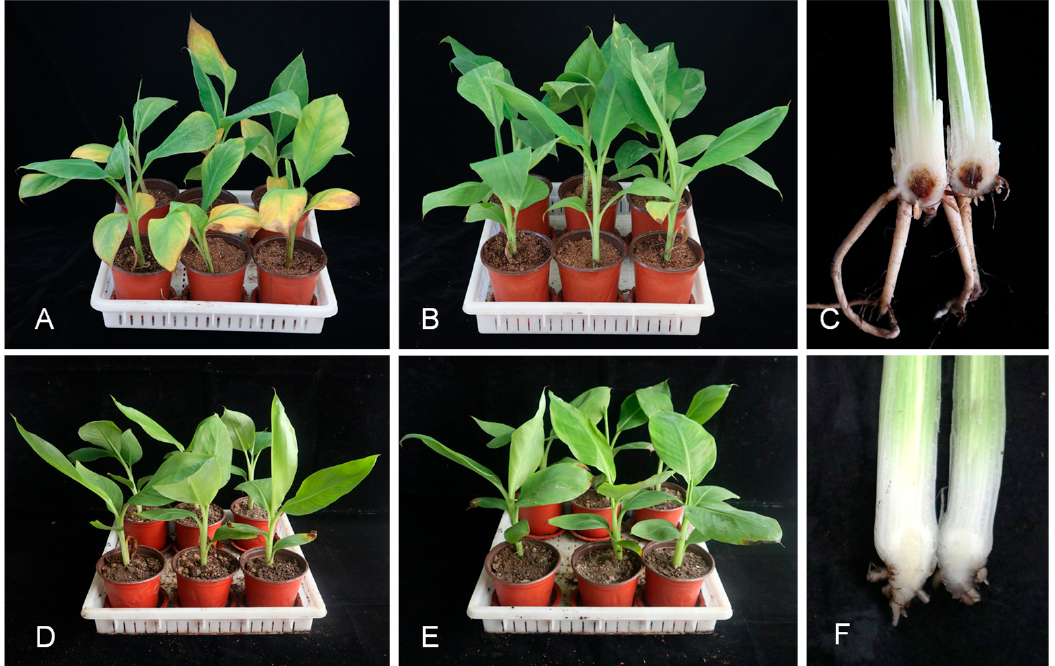
Figure 4. Pathogenicity test results on the Cachaco (ABB) and Williams (AAA) cultivars at the Institute of Plant Protection Research, Guangxi Key Laboratory of Biology for Crop Diseases and Insect Pests, Guangxi Academy of Agricultural Sciences, China. ( A – C ) Tests on Cachaco (ABB) cultivars; ( A ) inoculated; ( B ) non-inoculated; and ( C ) rhizome discoloration caused by Foc isolates after inoculation. ( D – F ) Tests on Williams (AAA) cultivars; ( D ) inoculated; ( E ) non-inoculated; and ( F ) no symptoms in the rhizome after inoculation.